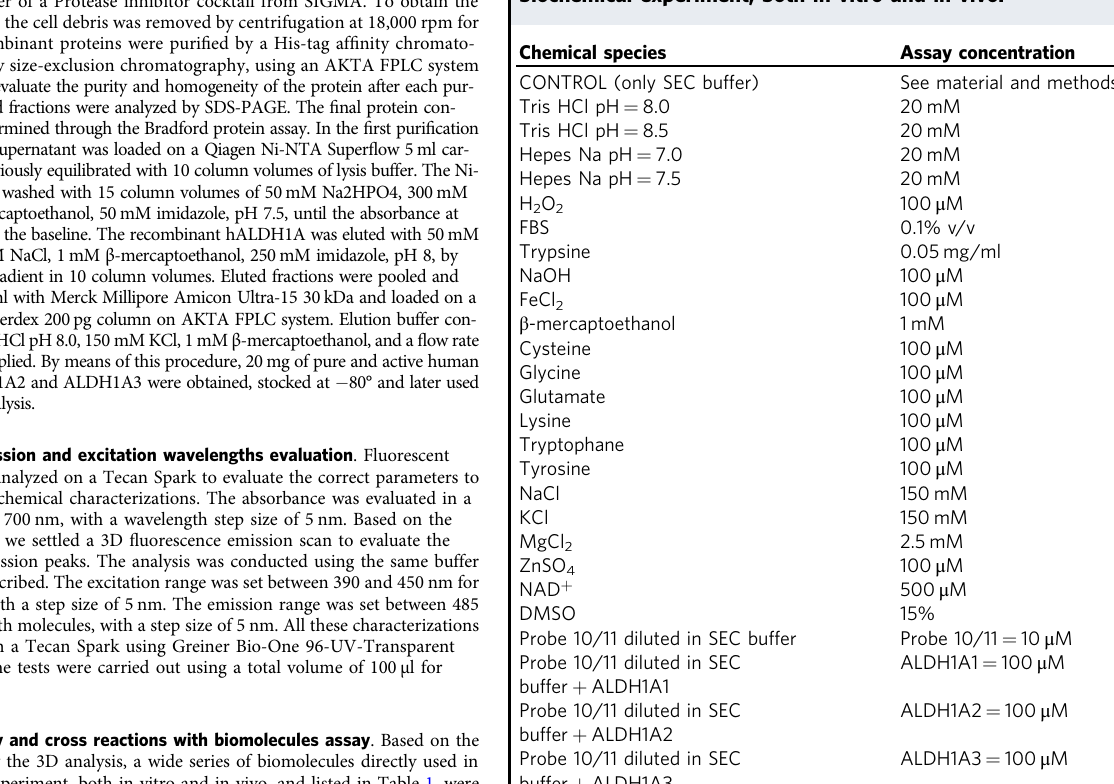
Table. 1 List of a several biomolecules directly used in the biochemical experiment, both in vitro and in